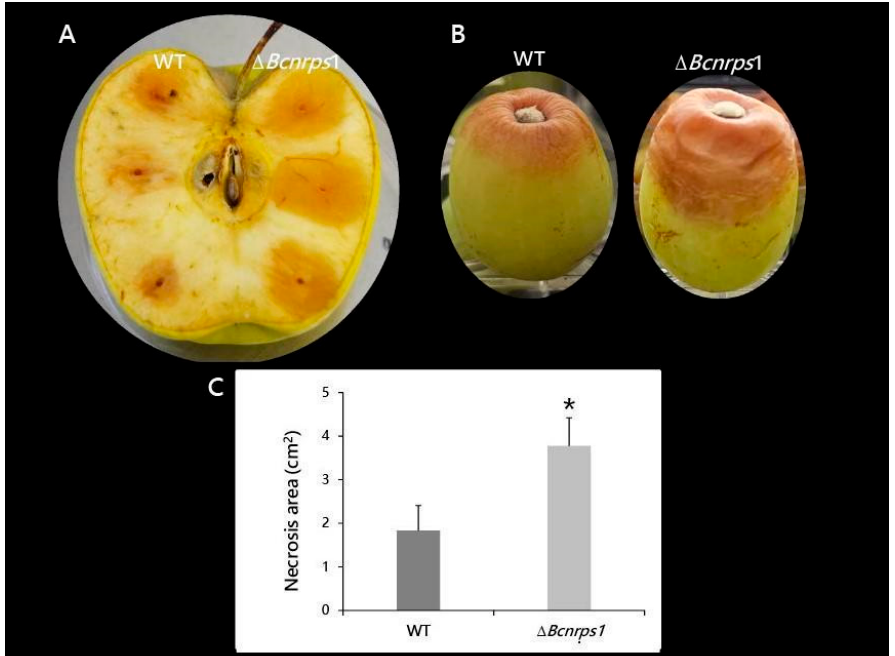
Figure 9. Pathogenicity test of B. cinerea B05.10 (WT) and Δ Bcnrps 1 strains in wounded pieces of ( A ) apple at 4 dpi and ( B ) white grape berries after 9 dpi. ( C ) Area of necrosis produced in apple by the strains at 4 dpi. Error bars represent standard deviations of means ( n = 3). Asterisks indicate significant differences between strains, according to the t -test ( p -value < 0.05, *).